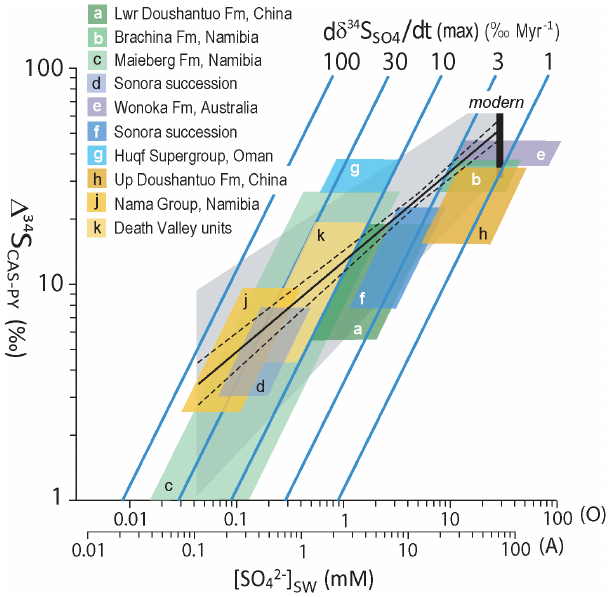
Figure 7. Analysis of seawater sulfate concentrations for eight Pa- leozoic marine units. The parallelogram for each unit was gener- ated using the rate method. The red field represents the long-term average (cid:49) 34 S CAS-PY for the Paleozoic based on data in Wu et al. (2010). A summary of results and data sources is given in Ta- ble S4; other details as in Figs.